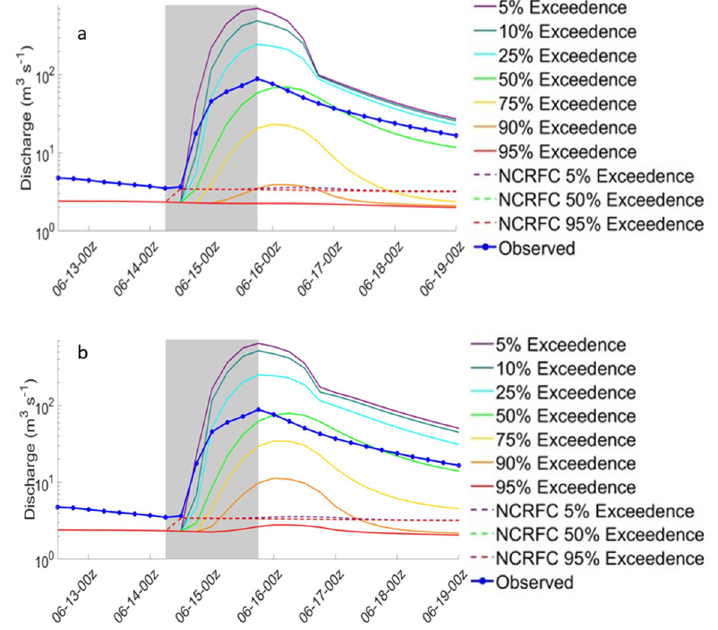
Figure 7. Hydrographs from all exceedance levels in the ( a ) HRRRE-based and ( b ) HREF-based forecasts for the 14 June 2018 event for Skunk River, with the NCRFC forecasts shown in dashed lines, and the observed discharge from the USGS gauge (solid blue line with closed circles). The gray box in the background signifies the time steps where PQPF was used. The y -axis displays the forecasted and observed discharges in a logarithmic scale, while the x -axis shows the date and time. Table 5. Error (m 3 s − 1 ) for Skunk River and Squaw Creek ensemble streamflow predictions for different probability of exceedance values for the 14 June event.